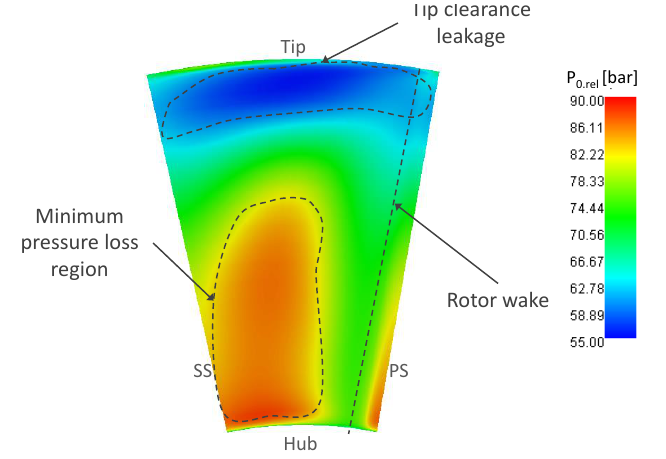
Figure 9. Relative total pressure contours at rotor exit stream section.